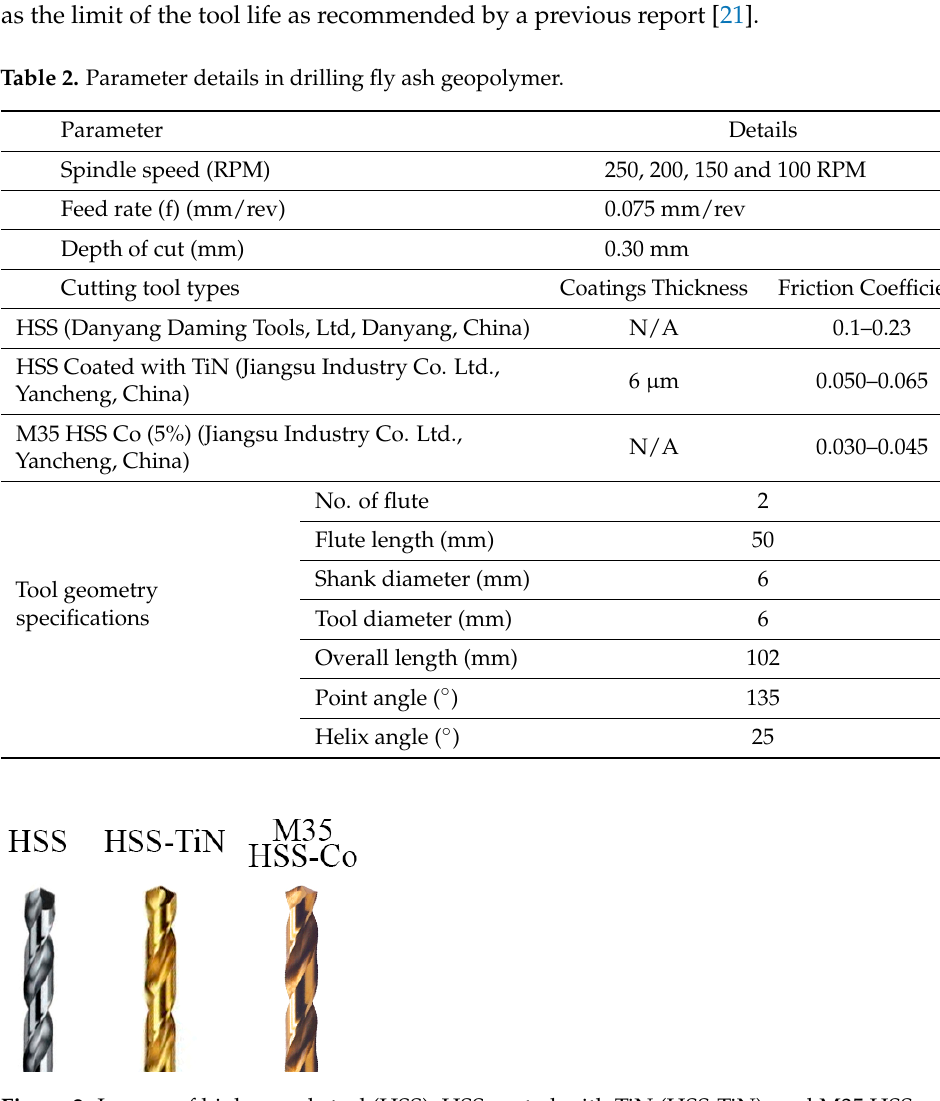
Figure 1. ( a ) Preparation process of geopolymer samples and ( b ) workpiece of fly ash geopolymer after solidified ready for drilling experiment.